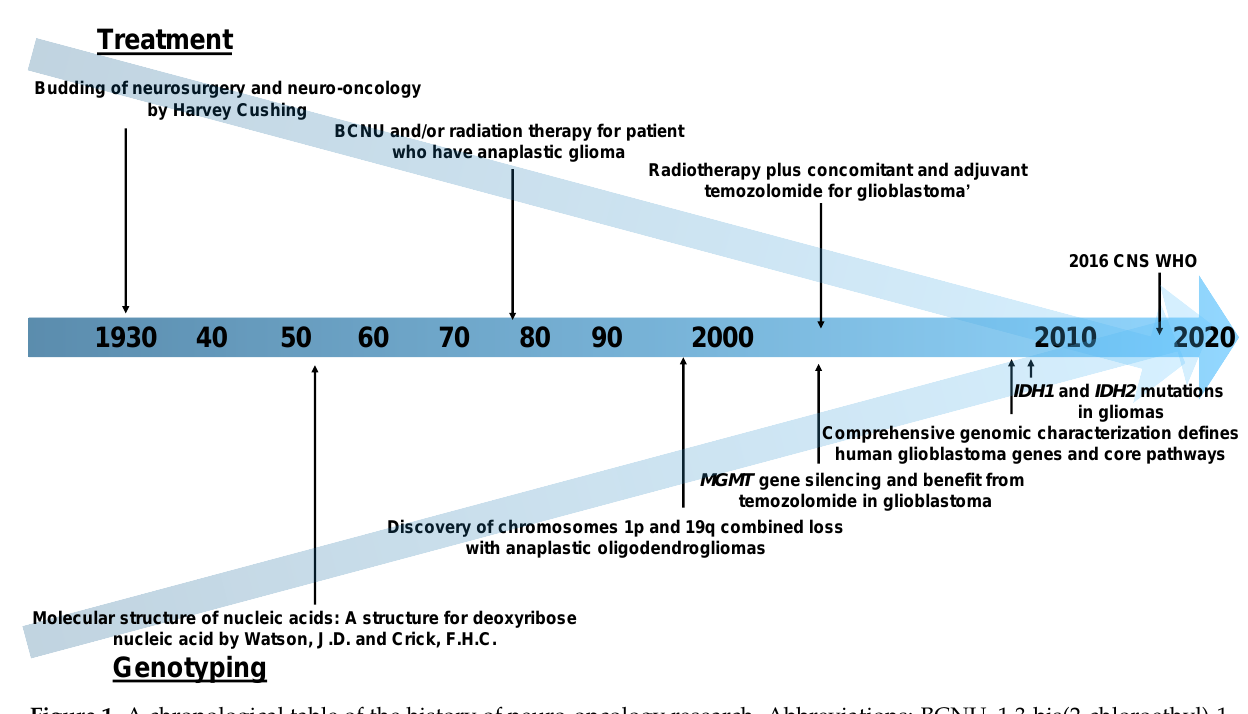
Figure 1. A chronological table of the history of neuro-oncology research. Abbreviations: BCNU, 1,3-bis(2-chloroethyl)-1- nitrosourea; MGMT, O 6 -methylguanine–DNA methyltransferase; IDH, Isocitrate Dehydrogenase; CNS WHO, World Health Organization Classification of the Central Nervous System.